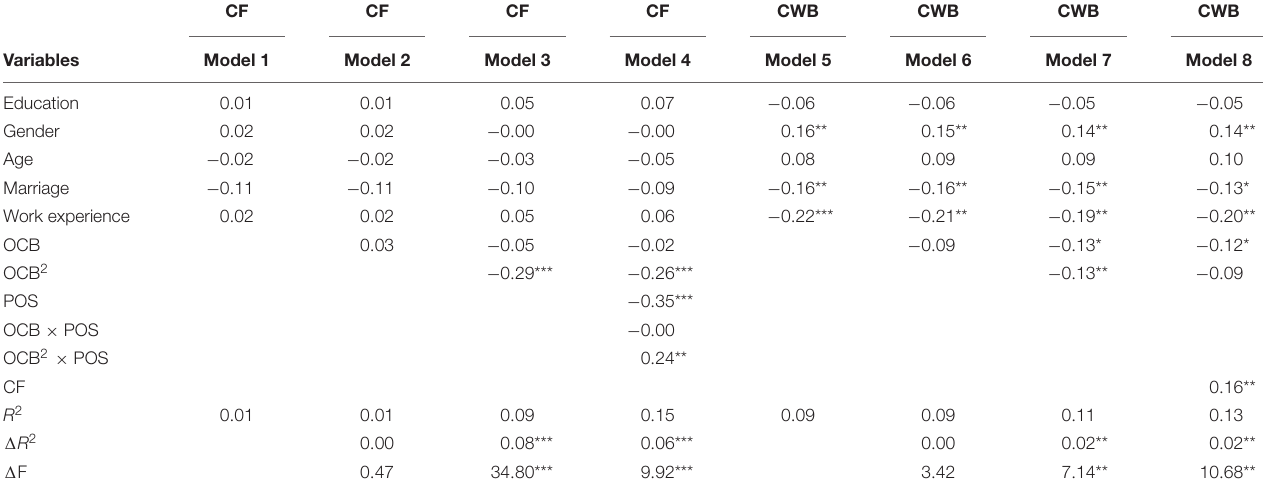
TABLE 2 | Results of hierarchical regression